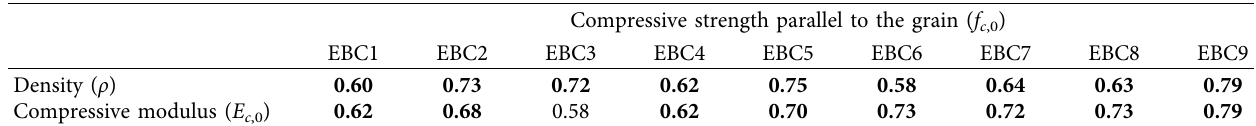
Table 7: Correlation coefficients ( R 2 ) between predictors and response for